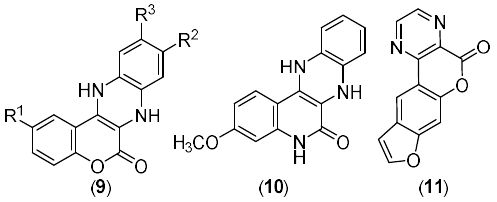
Figure 2. Some bioactive chromenopyrazines and quinolinopyrazines.